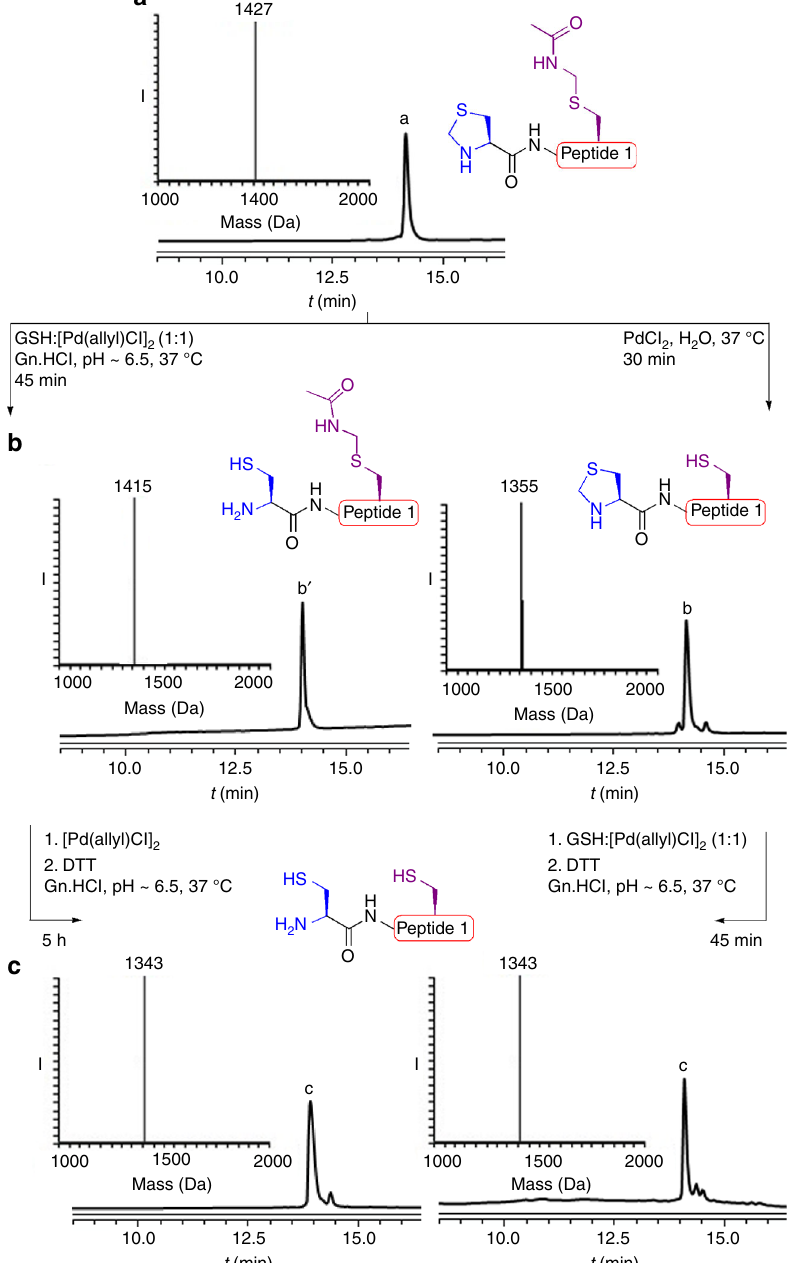
Fig. 1 On-demand deprotection of Thz and Acm PGs via palladium complexes. a Analytical HPLC and mass traces for protected peptide 1 with the observed mass 1427 ± 0.6 Da, calcd 1427 Da (average isotopes). b Analytical HPLC and mass traces for Thz or Acm deprotection via palladium with the observed masses 1415 ± 0.3 Da, and 1355 ± 0.5 Da, calcd 1415 Da and 1356 Da (average isotopes), respectively. c Analytical HPLC and mass traces for Acm or Thz deprotection via palladium with the observed masses 1343 ± 0.6 Da, calcd 1344 Da (average